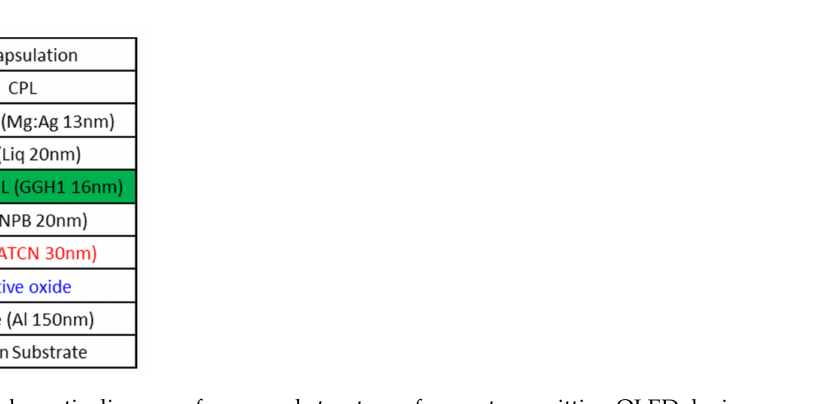
Figure 1. Schematic diagram of proposed structure of green top emitting OLED device.